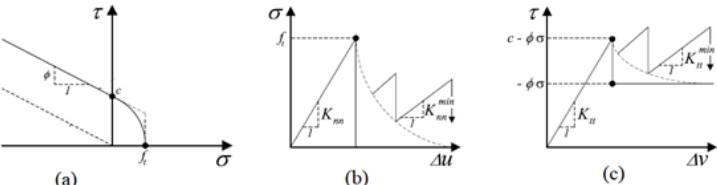
Figure 3. (a) Rupture surface of the interface element. Behavior of the interface model subject to normal stress (b) and shear stress (c). Adapted from Cervenka et al. [26].